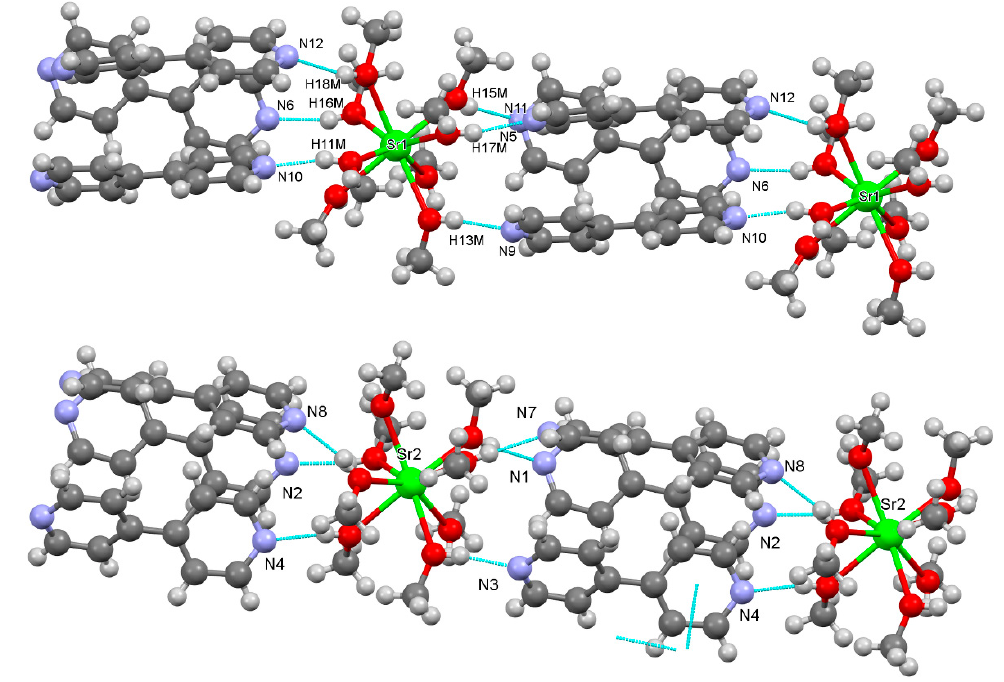
(cid:48) -bipy) 3 ] x